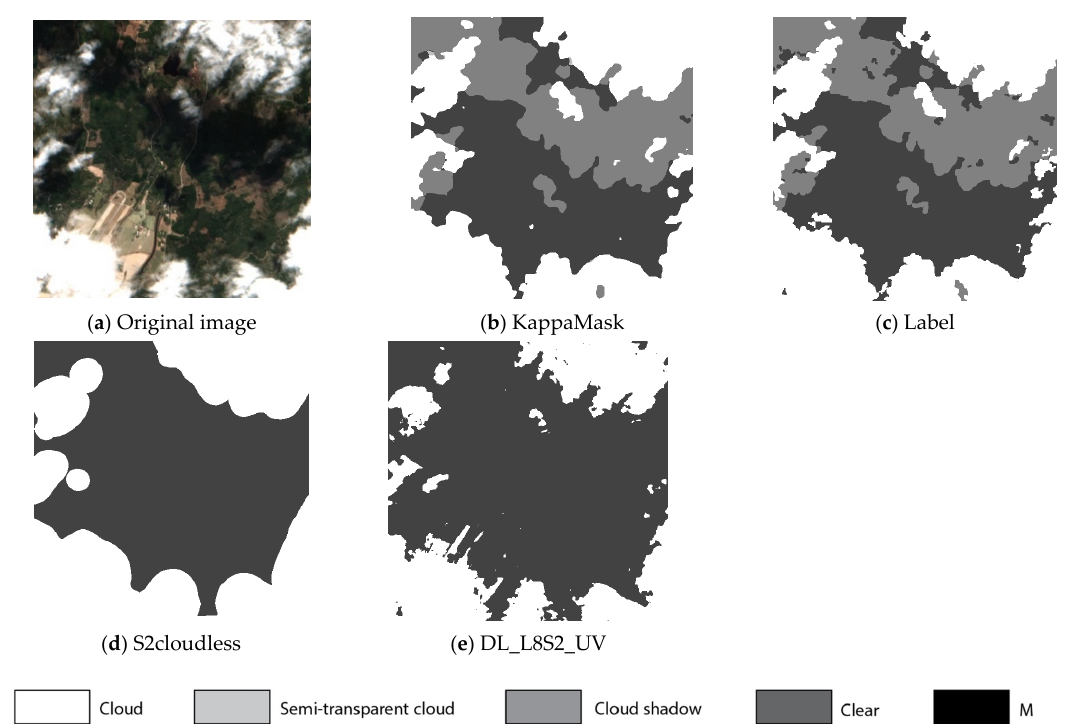
Figure 9. Comparison of L2A prediction output for a 512 × 512 pixels sub-tile in the test dataset. ( a ) Original Sentinel-2 L2A True-Colour Image; ( b ) KappaMask classification map; ( c ) Segmentation mask prepared by a human labeller; ( d ) S2cloudless classification map; ( e ) DL_L8S2_UV classification map.